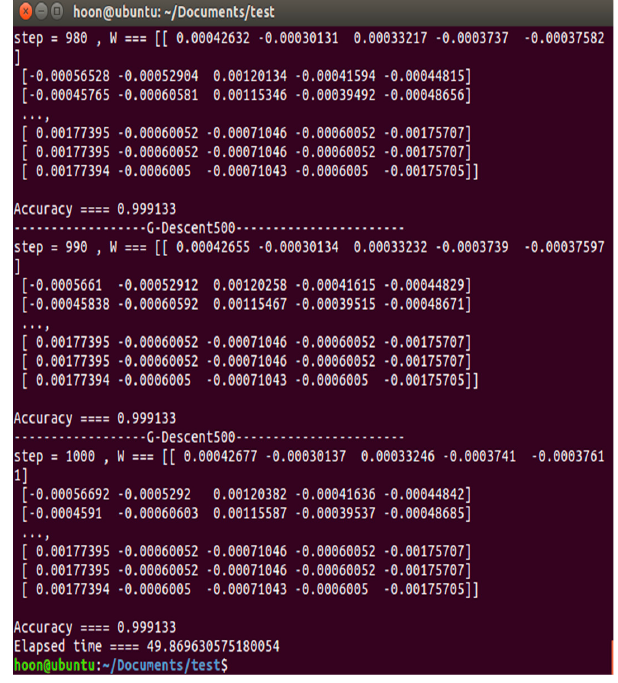
Figure 18. Scenario 4 experiment result: noise learning (Adam ⇒ G-Descent).